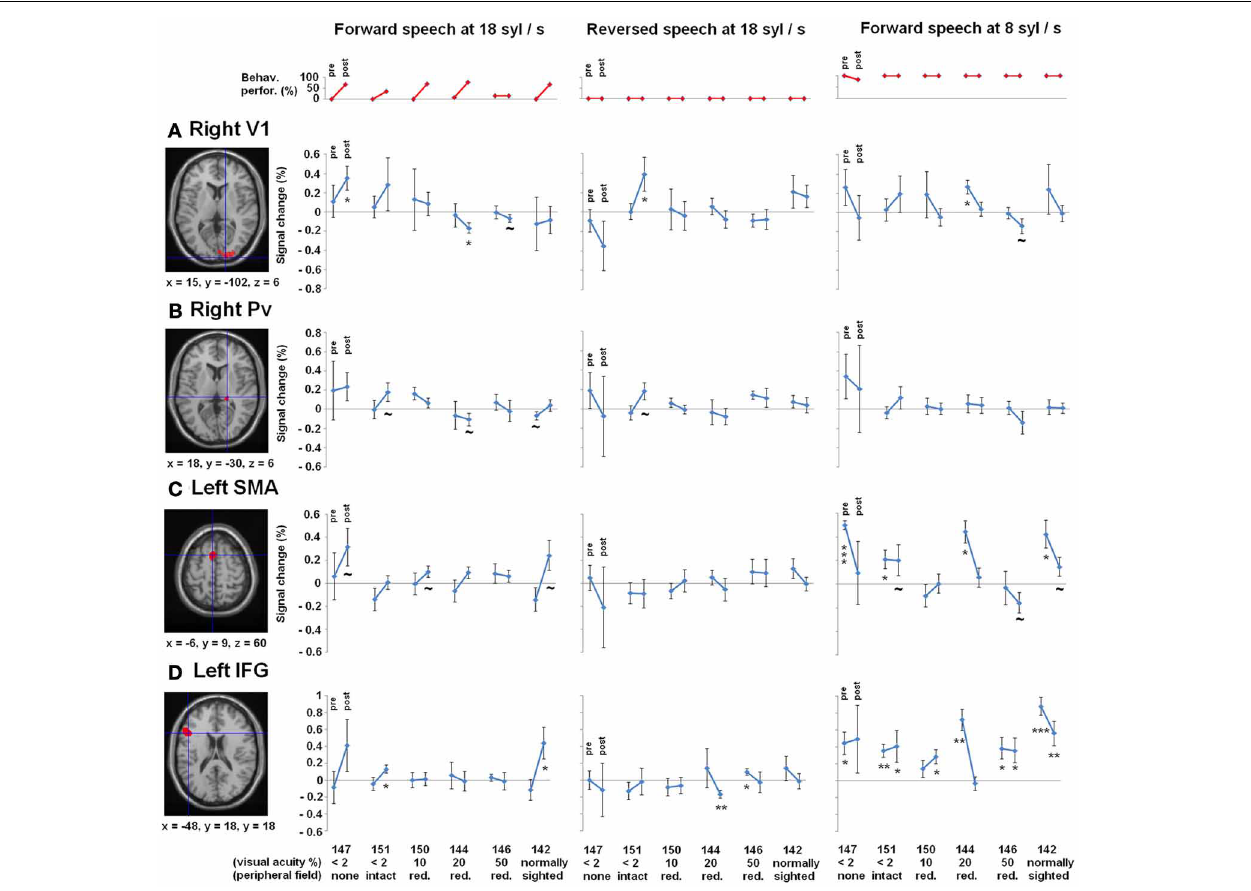
FIGURE 4 | Regions-of-interest (ROI) analyses, (A) right primary visual area (V1) and (B) right pulvinar (Pv), (C) left supplementary motor area (SMA)aswellasthe(D)leftinferiorfrontalgyrus(IFG)—allclustersderived from Dietrich et al. (2013), overlaid on an anatomical T1 template. Upper plot (red): Behavioral performance of understanding ultra-fast speech (18syl/s)